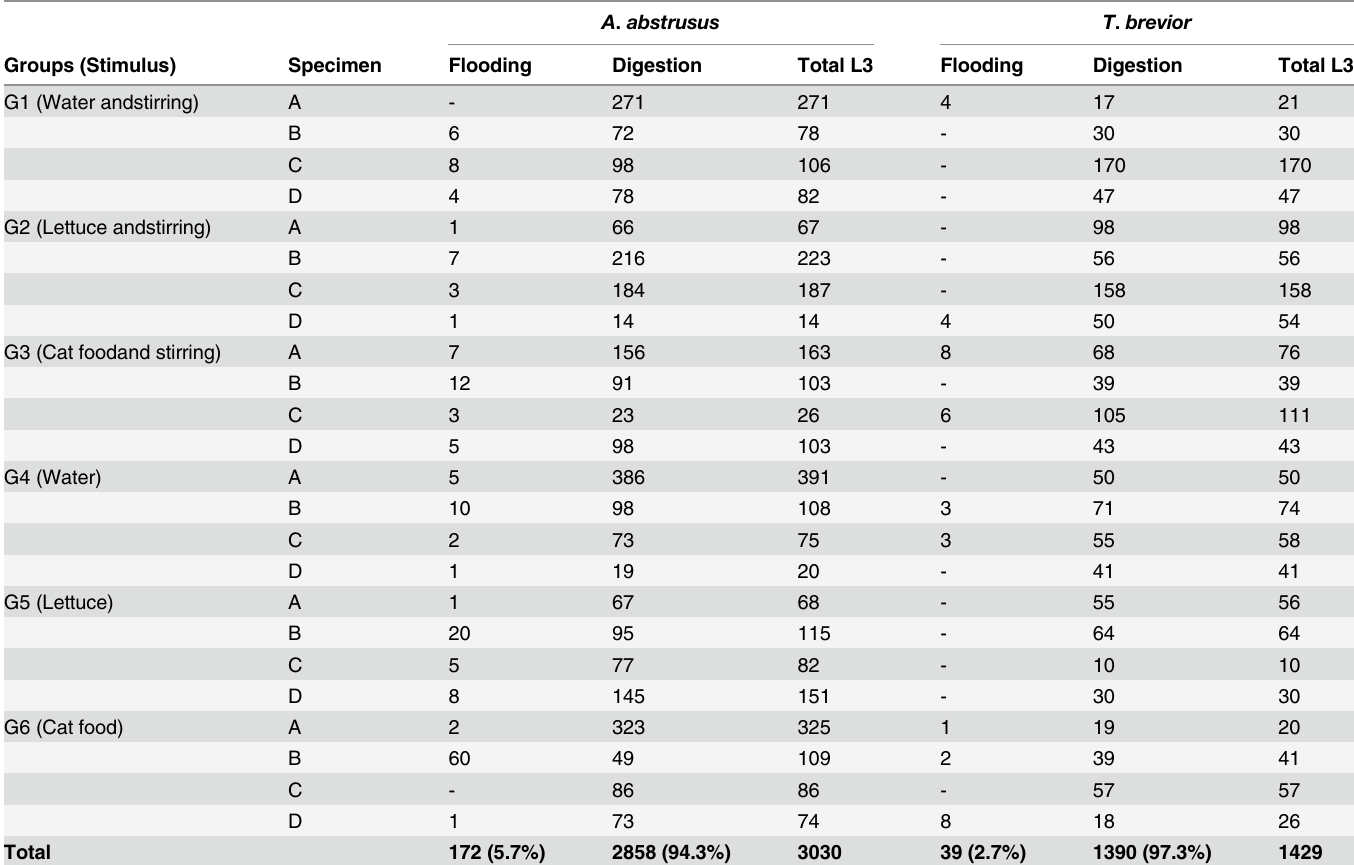
Table 2. Total number and percentage of Aelurostrongylus abstrusus and Troglostrongylus brevior L3 detected in each snail specimens from dif- ferent groups following water flooding and digestion examinations. A . abstrusus T . brevior Groups (Stimulus) Specimen Flooding Digestion Total L3 Flooding Total L3 G1 (Water